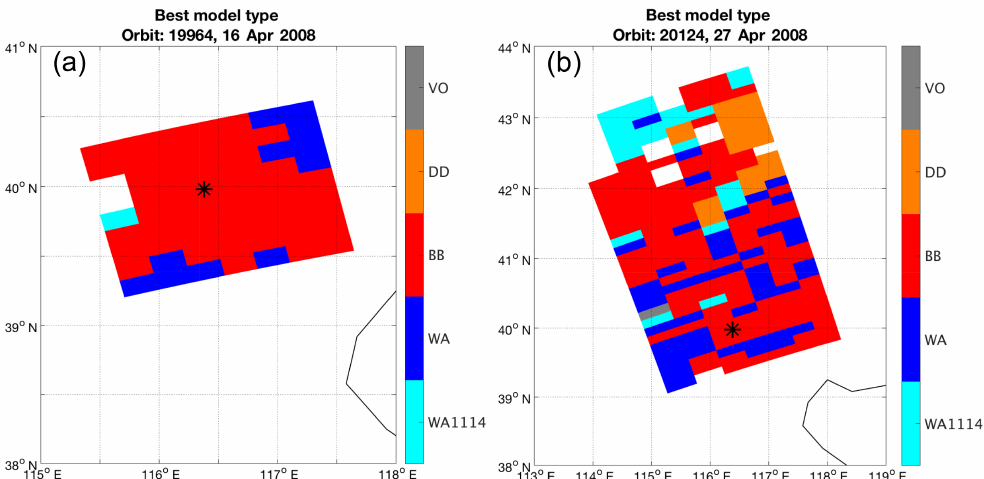
Figure 3. The main aerosol type of the retrieved model with the highest amount of evidence, i.e. the best model on 16 April (a) and 27 April (b) . The main aerosol types are WA1114 (weakly absorbing sea salt), WA (weakly absorbing), BB (biomass burning), DD (desert dust) and VO (volcanic). The location of the AERONET site Beijing, China (see Table 2) is marked by a black